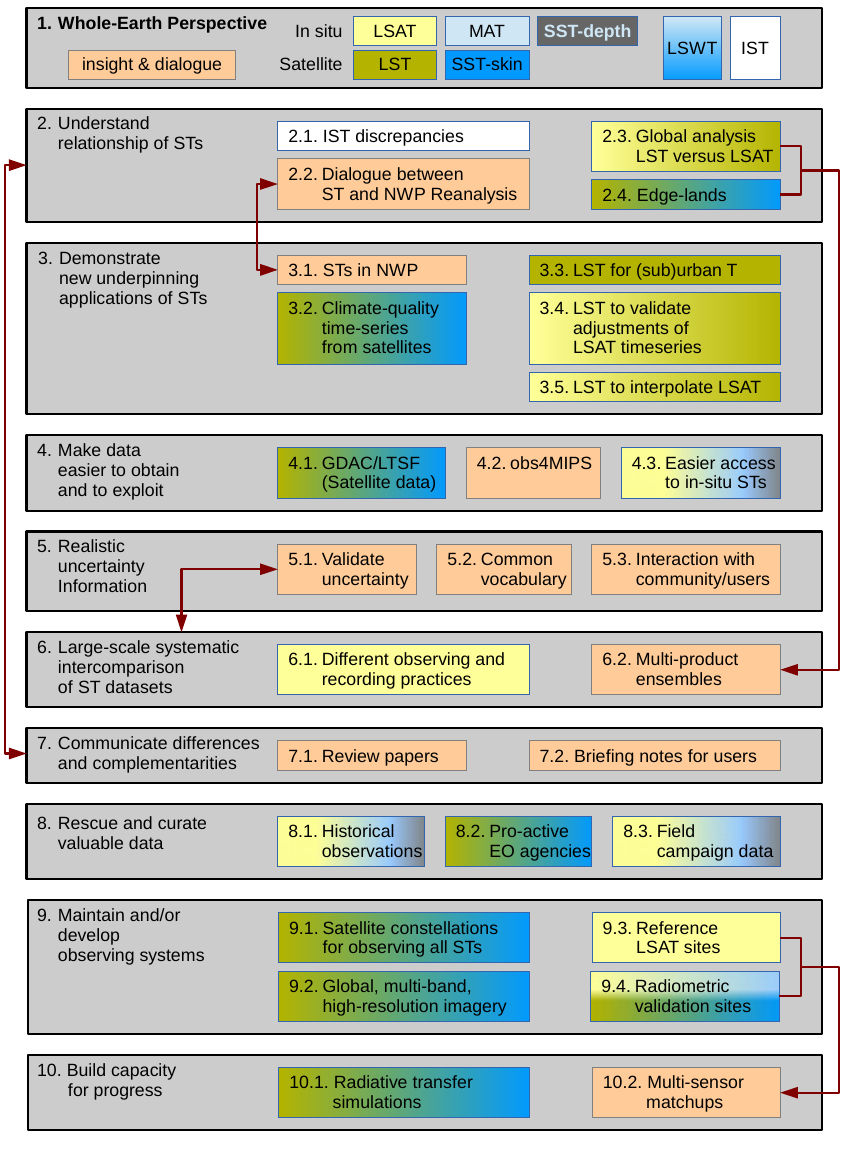
Fig. 2. Graphical overview over the recommendations. The colours indicate the measurement types for which a recommendation is particu- larly (but not always exclusively) relevant. Lighter shades (yellow and light blue) refer to in situ observations, and darker shades (olive and dark blue) to satellite-based measurements. Yellow and olive shades refer to land domains, and blue shades to ocean domains (and lakes). Boxes with colour gradients contain recommendations covering two or more types: darker-olive–blue gradients refer to satellite measure- ments over both land and sea, the lighter yellow–blue–grey gradients refer to in situ land and marine temperatures, and yellow–olive boxes link satellite and in situ measurements over land. Orange boxes are general recommendations spanning most temperature measurements. Arrows connect recommendations that are closely